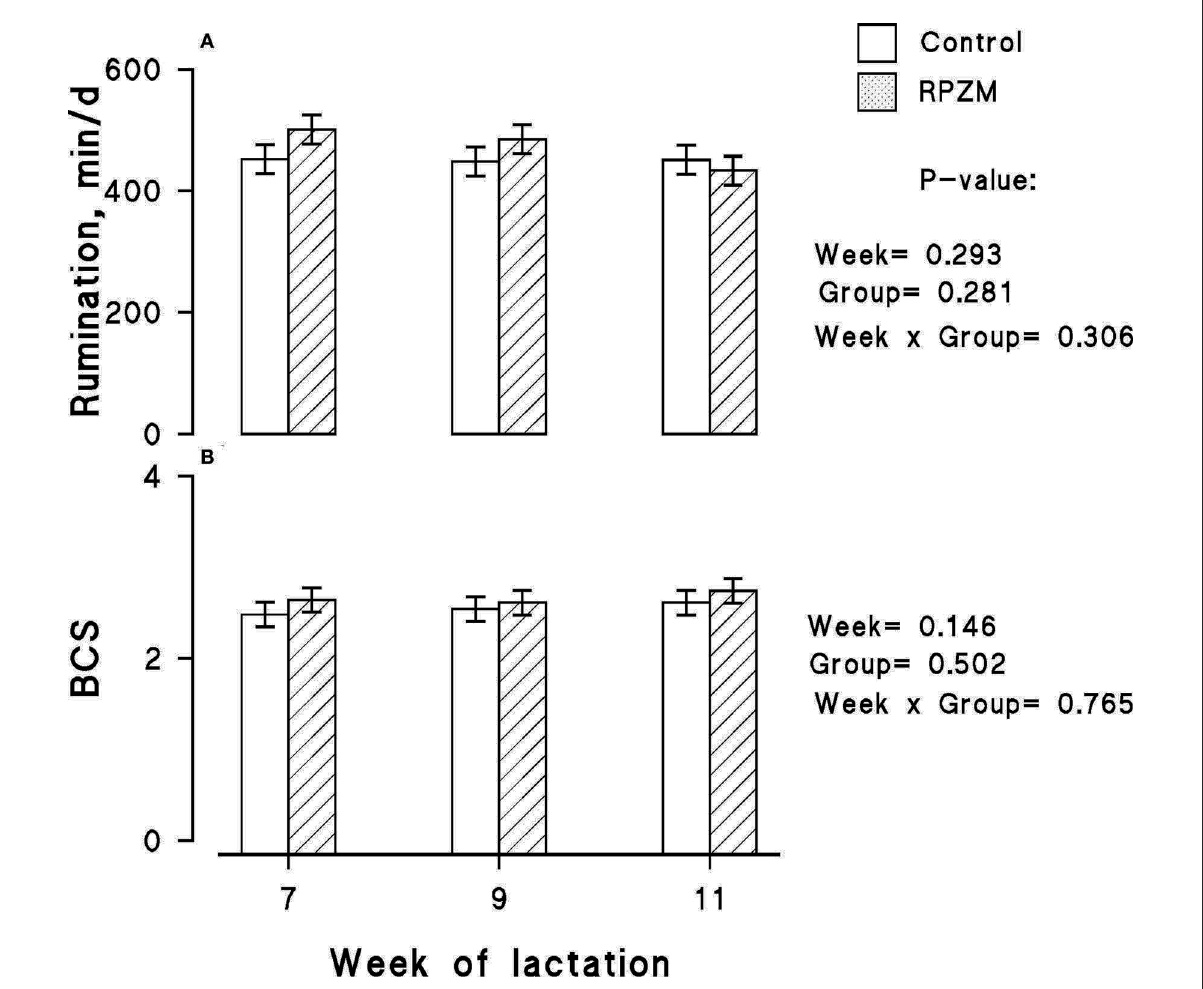
FIGURE3 Rumination time (A) and body condition score (BCS; B ) of high-producing Holstein cows supplemented without (control) or with rumen-protected zinc–methionine complex (RPZM) during long-term environmental heat stress. Values are means ± standard error of means.